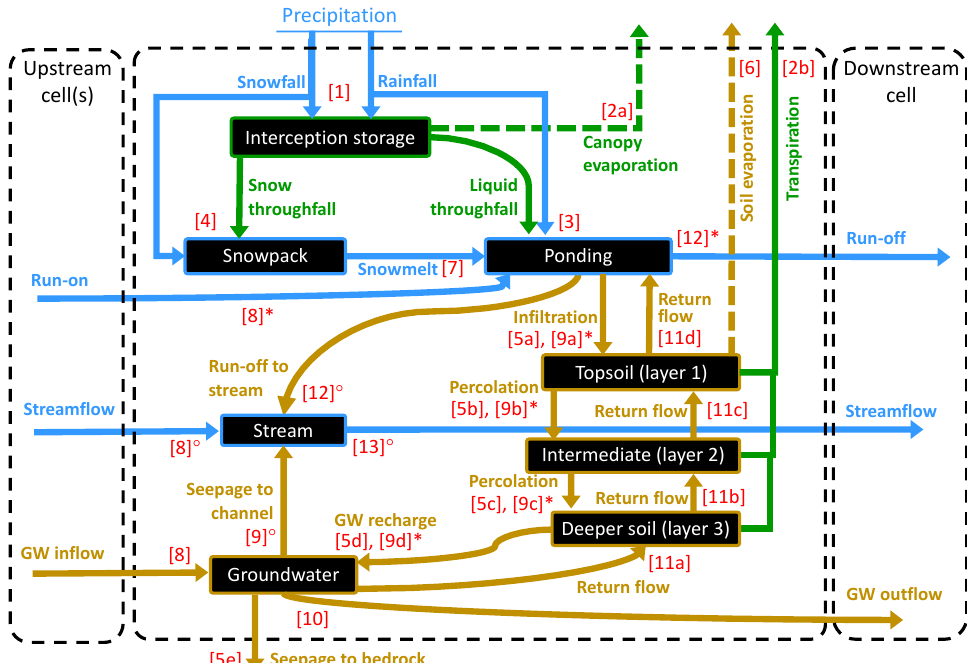
Figure 1. Water compartments (black rectangles) and fluxes (coloured arrows) as represented in EcH 2 O-iso, with the dashed arrows indicat- ing processes where isotopic fractionation is simulated. The numbers between brackets reflect the sequence of calculation within a time step. Note that water routing (steps 8 to 13) differs between cells where a stream is present ( (cid:13) ) or not ( ∗